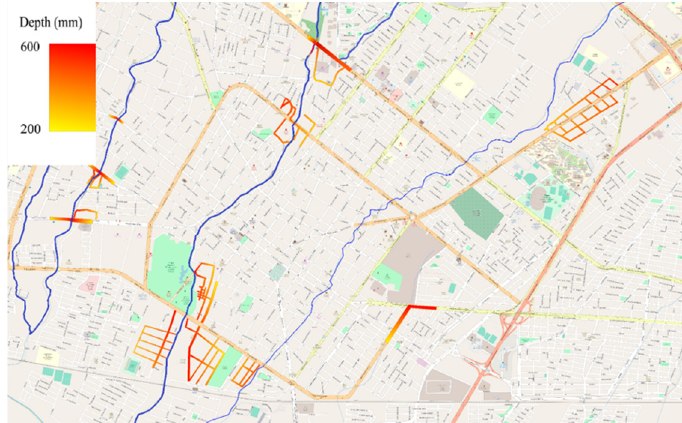
Figure 2. Flooded zones (streets) in Colima-Villa de Alvarez area by flash flooding events.